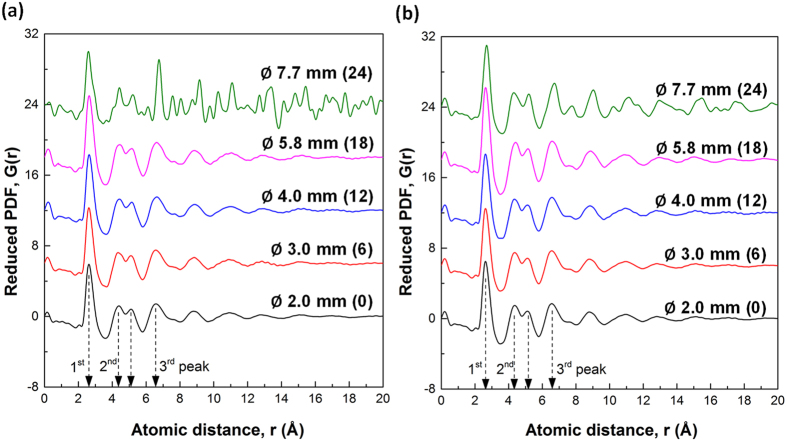
Reduced pair distribution function, G(r), calculated from the 1D SXRD profiles for different diameter sections of the step-bars of (a) Fe-B6Gd2 and (b) Fe-B6Y2 alloys.